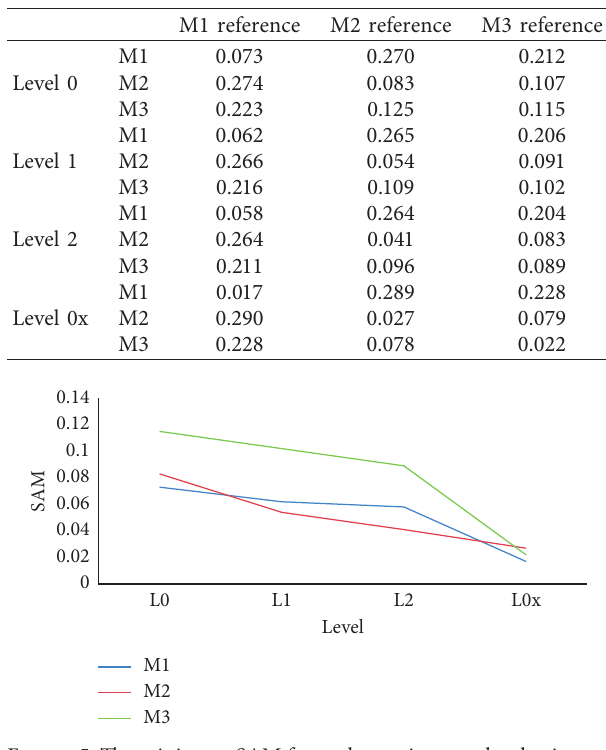
Figure 5: The minimum SAM for each type in every level using an internal reference. Table 4: Results of SAM using an external reference which is a spectrum with a reflectance equaling to unity across the entire spectral